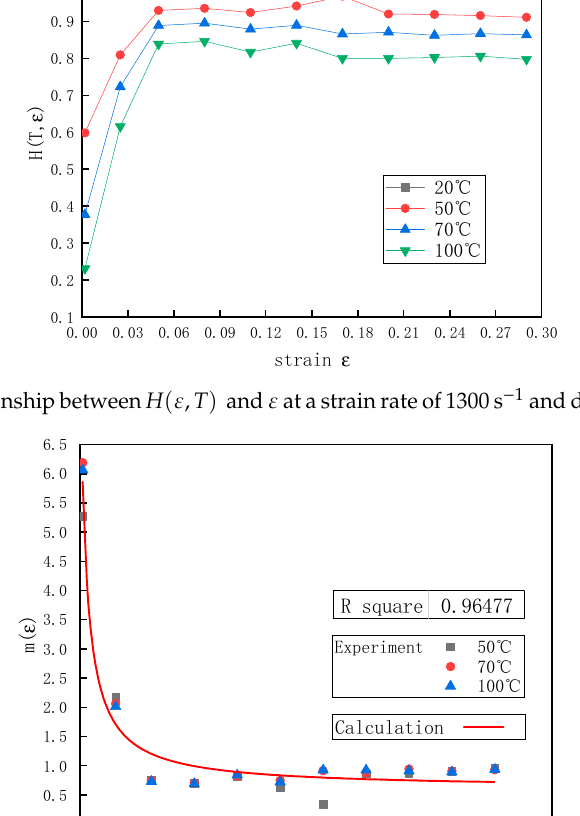
Figure 10. The relationship between 𝐻(𝜀,𝑇) and 𝜀 at a strain rate of 1300 s − 1 and different temperatures.